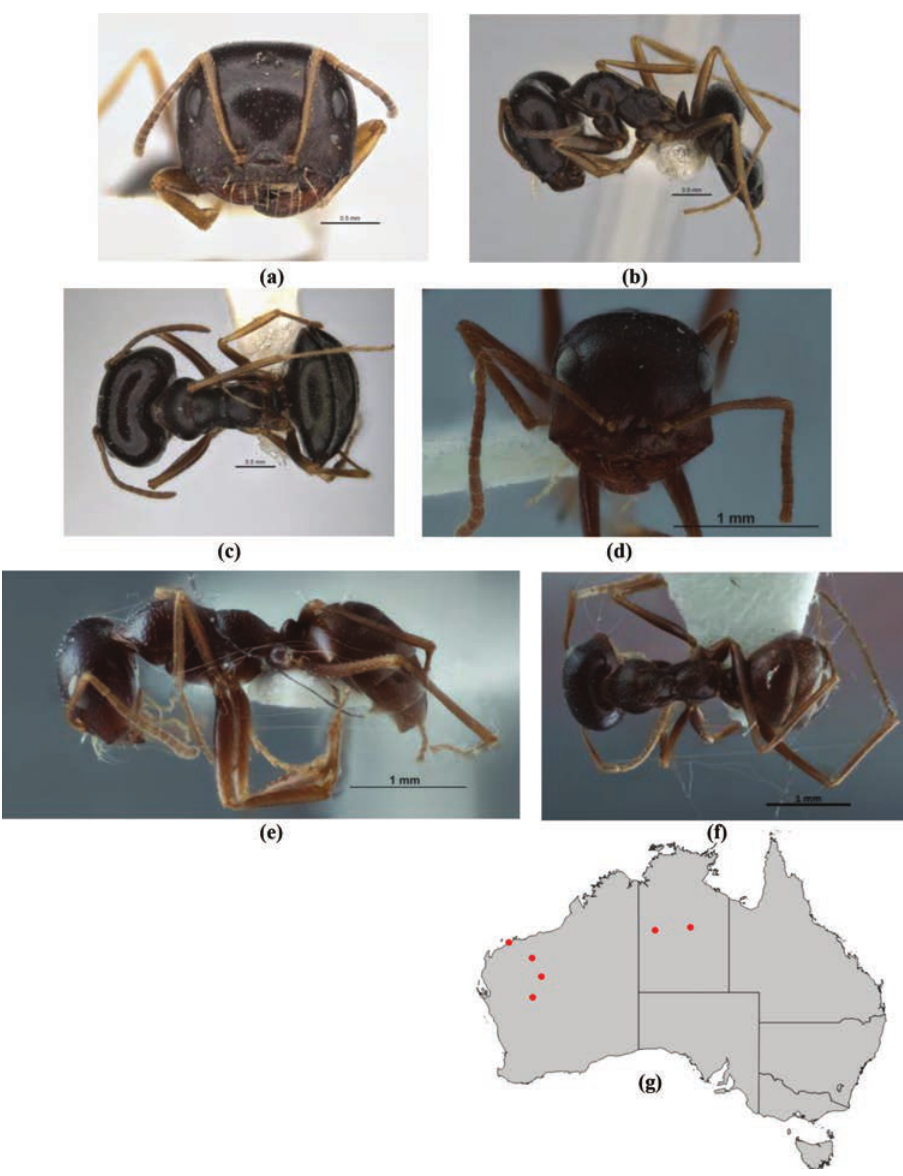
Figure 83. Melophorus parvimolaris sp. n.: major worker paratype (ANIC32-900134) frons ( a ), pro- file ( b ) and dorsum ( c ); minor worker holotype (JDM32-004558–top ant) frons ( d ), profile ( e ) and dorsum ( f ); distribution map for the species ( g ). Low resolution scale bars: 1 mm ( a–c ).